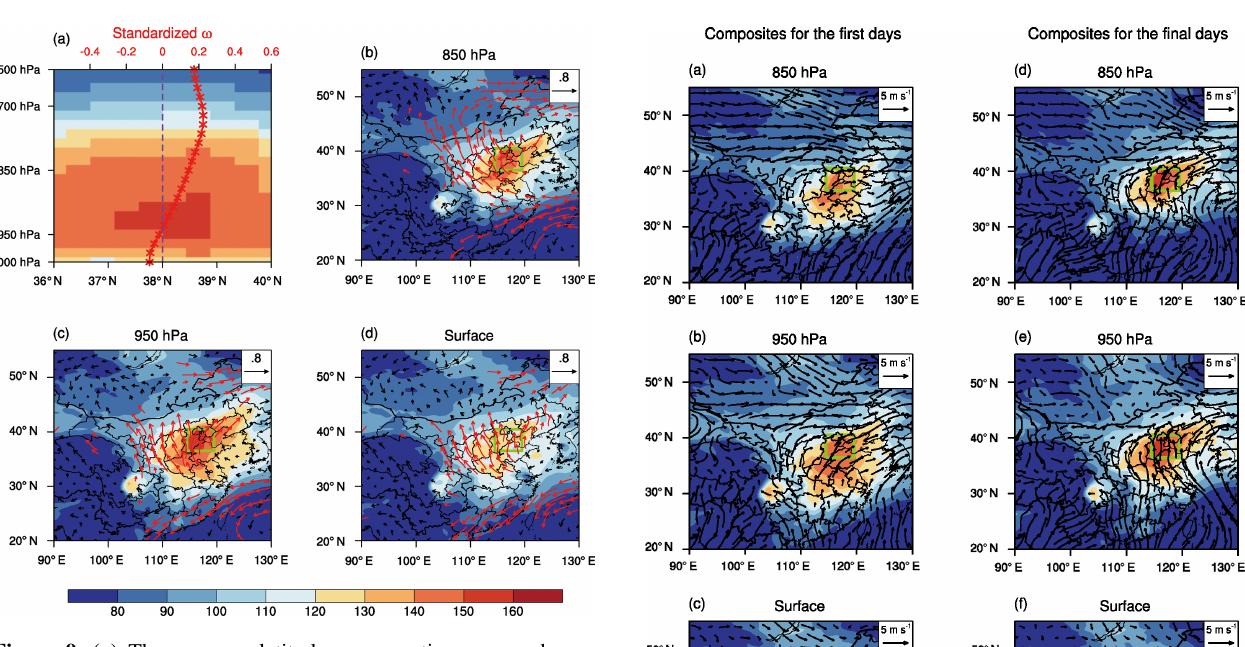
Figure 9. (a) The pressure–latitude cross section averaged over the longitudes of 114.5–119.5 ◦ E of simulated daily mean O 3 con- centrations (µgm − 3 ) during the 15 OPEs that are captured by the GEOS-Chem model with I_OPE > 0. The red line with asterisks shows the anomalous profile of the regionally averaged vertical pressure velocity ( ω , Pas − 1 , positive value indicates downward air- flow) in North China. The dashed purple line indicates the position where the standardized ω is zero. Panels (b) – (d) show anomalous winds and the simulated daily mean O 3 concentrations during OPEs at (b) 850hPa, (c) 950hPa and (d) the surface. The solid green lines indicate North China. ω in (a) and winds in (b) – (d) are compos- ited over the standardized time series during the months of May to July of 2014–2017 (see Sect. 2.2). The red vectors in (b) – (d) are significant winds at 95% confidence.